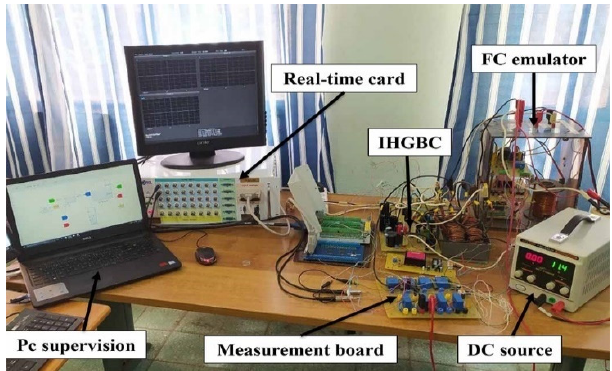
Figure 9. Experimental test bench.